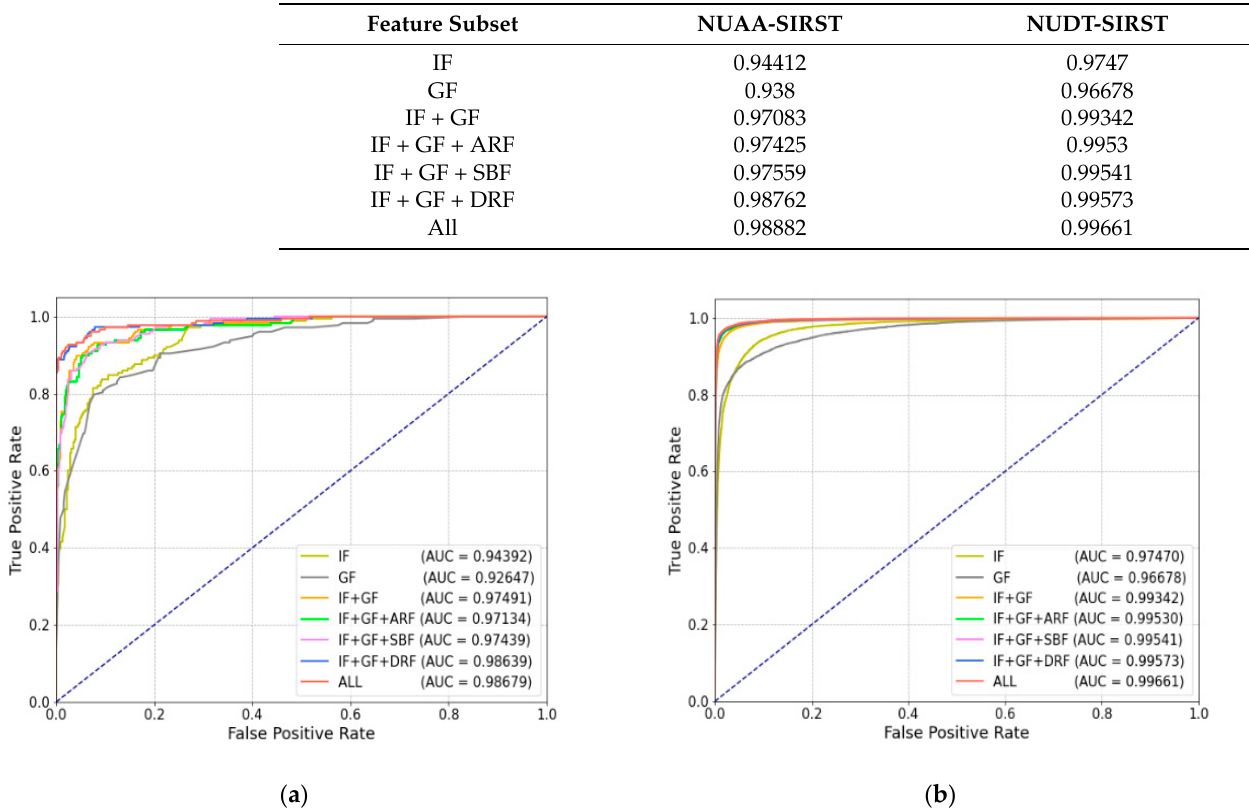
Table 4. Candidate classification results.